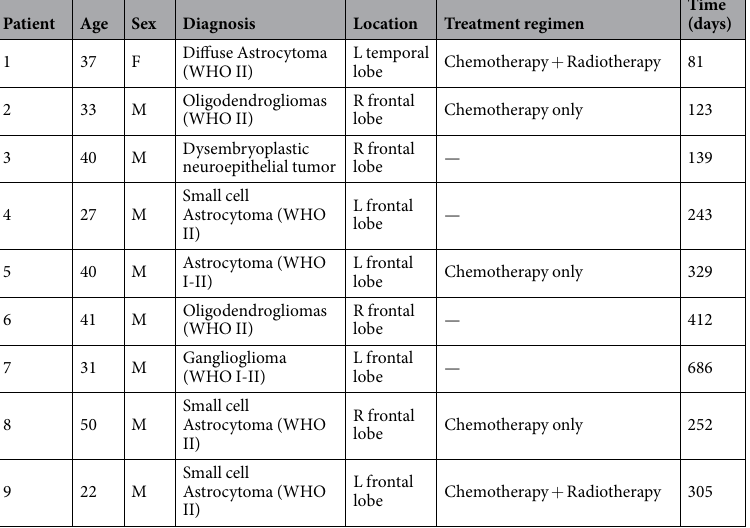
Image preprocessing.